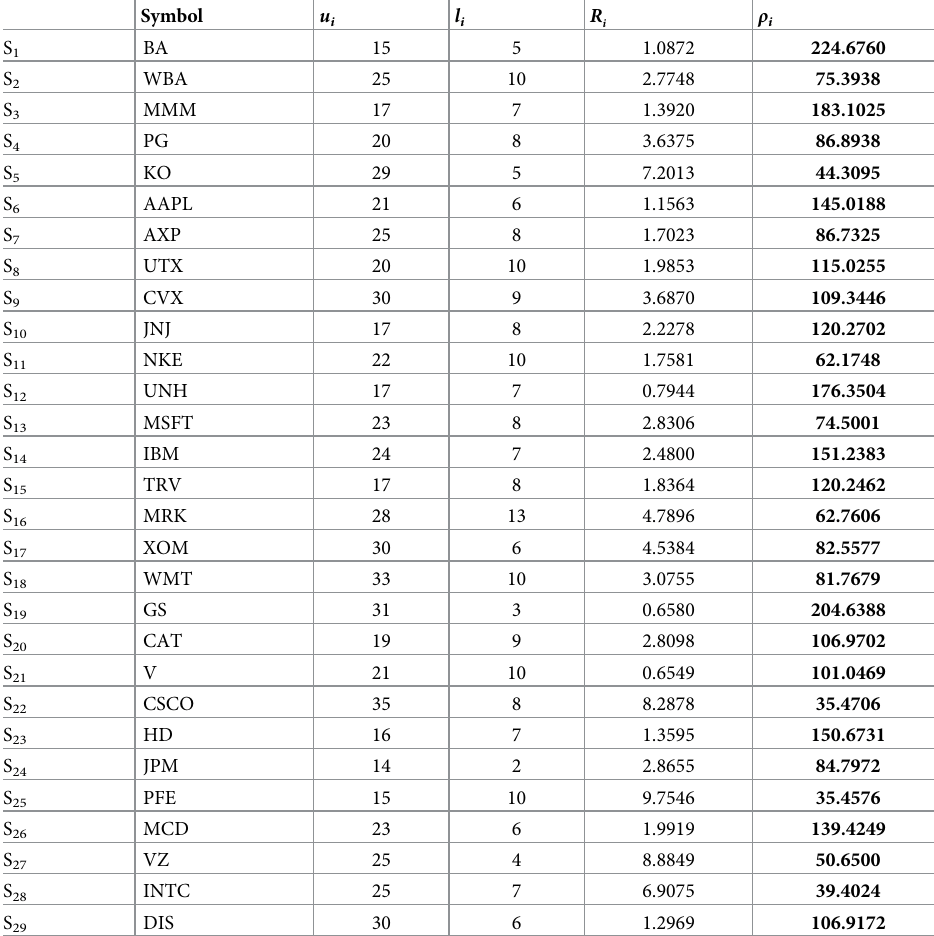
According to Table 4, the answers of y � budget intervals and selected λ for each L. Therefore, there is no error in this part. However, there is a difference in the selected number of each selected share ð x � tors that affect the objective function is x � Table 3. Information on Dow Jones